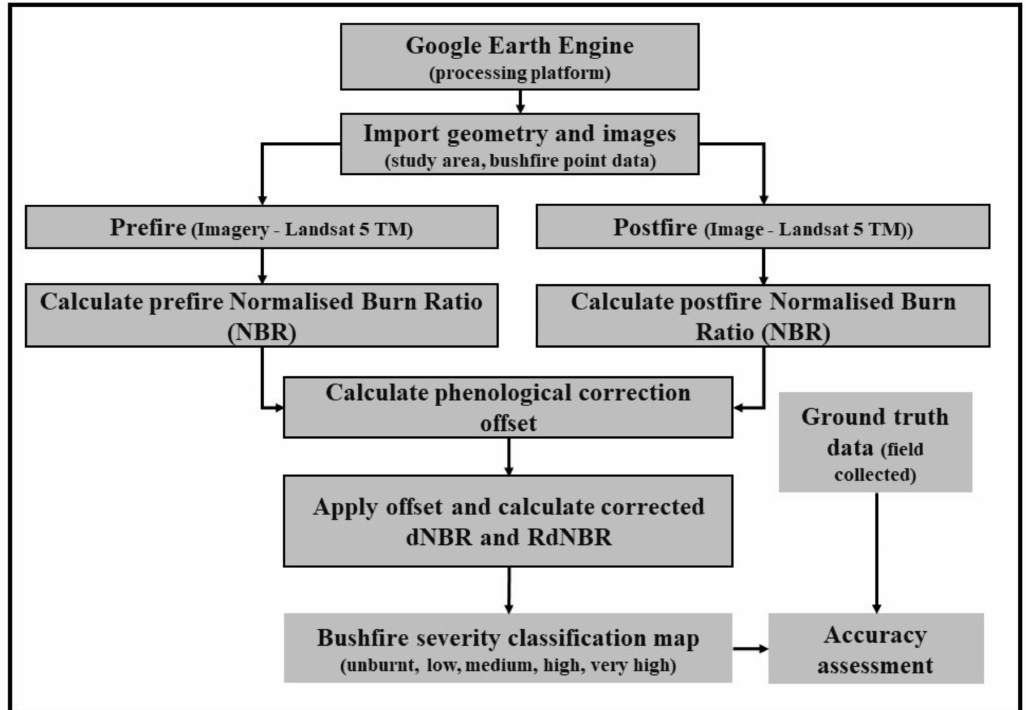
Figure 2. Methodological flowchart for generating bushfire burn severity target variable. The dNBR and RdNBR indices are produced by computing and applying phenology correction offset following Parks et al. (2018). The severity index giving higher accuracy against ground truth data is further prepared and utilised as the target